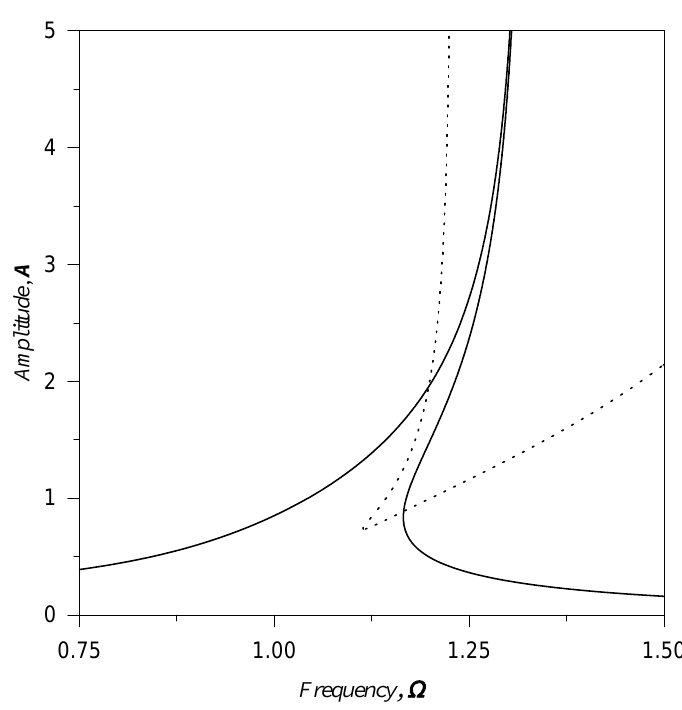
Fig. 6. Same as Fig. 4, but for ε 1 = 0 . 85 and ε 2 = 1 . 0